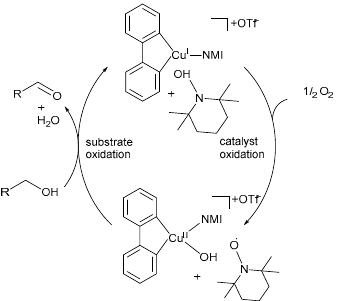
Scheme 17. A simplified version of the mechanistic pathway for the (bpy)Cu I / TEMPO · / NMI-catalysed aerobic alcohol oxidation. Reproduced with permission from Stahl and co-workers [11].